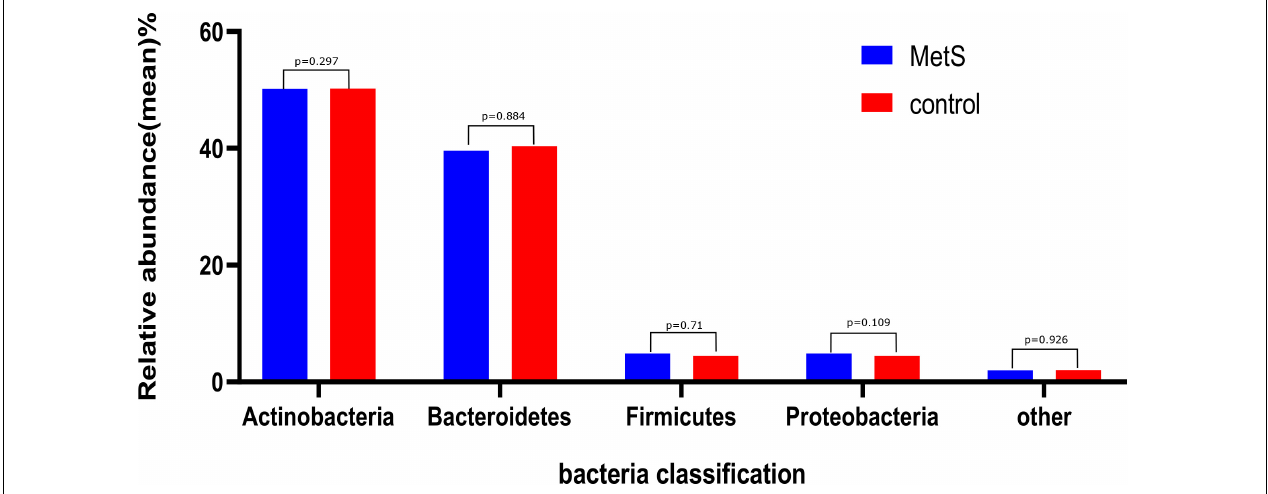
FIGURE 1 | The gut microbiota composition of the MetS and control groups. In both the MetS and control groups, gut microbiota was dominated by four abundant phyla, namely, Bacteroidetes (50.22 and 50.15%), Firmicutes (40.40 and 39.60%), Proteobacteria (4.50 and 4.88%), and Actinobacteria (2.32 and 2.19%). There were no significant differences in the phyla of the MetS compared to the control group ( p > 0.05).